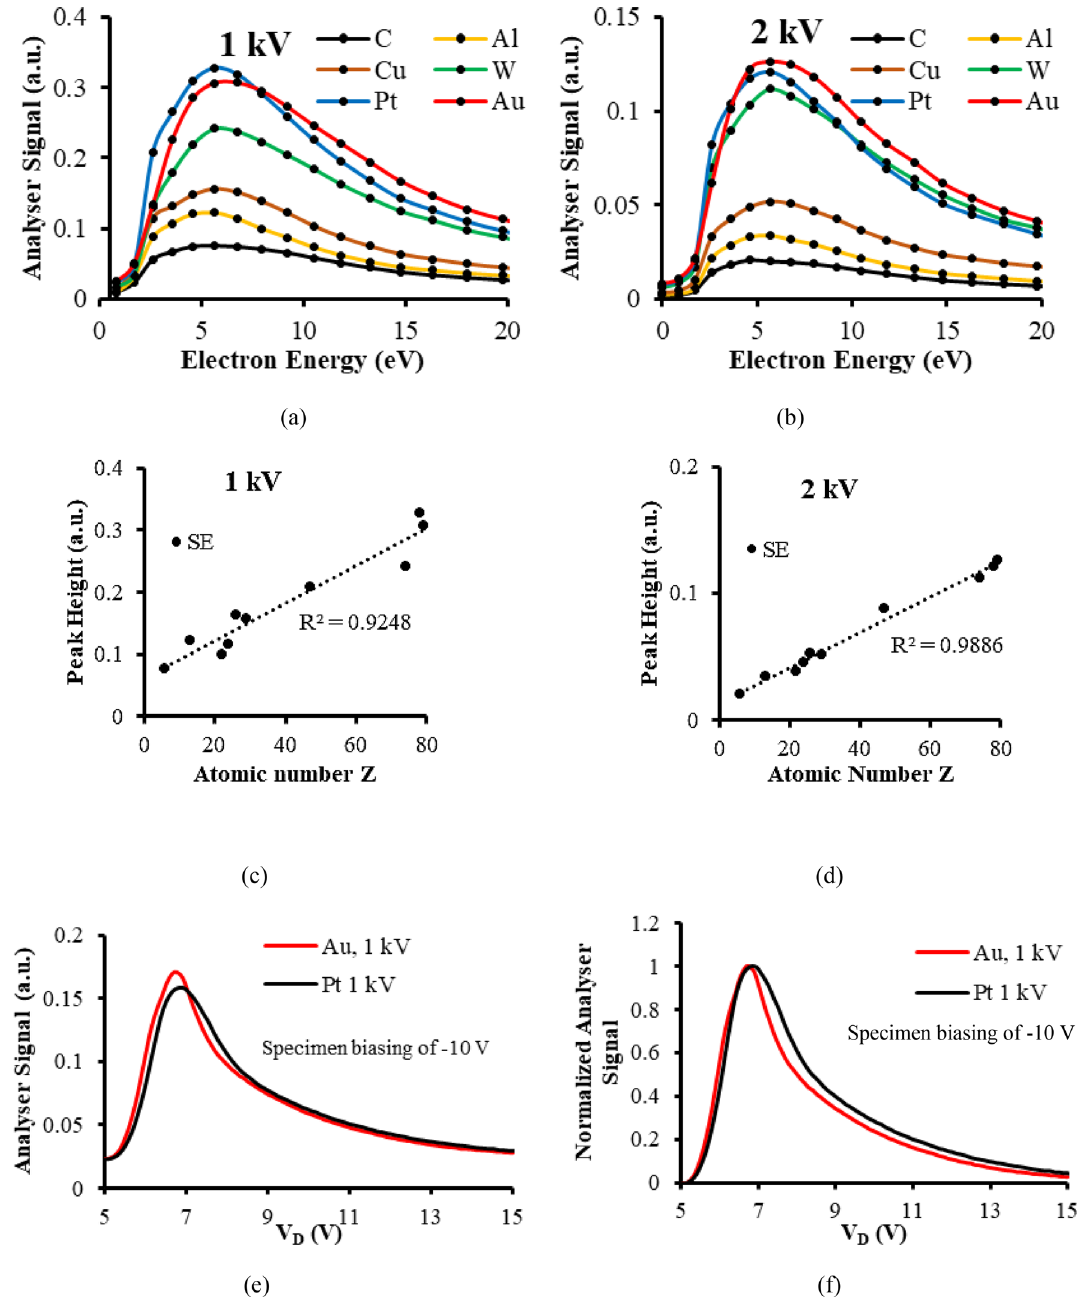
Figure 1. Quantitative material contrast extracted from energy analyser spectral signals ( a ) Experimental energy analyser spectra at a primary beam voltage of 1 kV for 6 different metals with 0 V specimen bias ( b ) Experimental energy analyser spectra at a primary beam voltage of 2 kV for 6 different metals with 0 V specimen bias ( c ) Spectral peak height variation with atomic number at a primary beam voltage of 1 kV ( d ) Spectral peak height variation with atomic number at a primary beam voltage of 2 kV ( e ) Experimental energy analyser spectra at a primary beam voltage of 1 kV for Pt and Au metal foil specimens with a − 10 V specimen bias ( f ) The normalised experimental energy analyser spectra shown in ( e